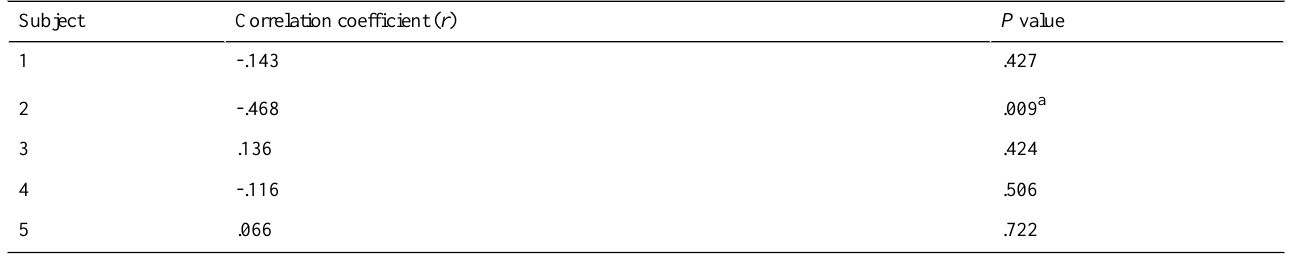
Table 2. Number of breaks in sleep/rest between 10 p.m. and 8 a.m. correlated with medication-taking adherence the next